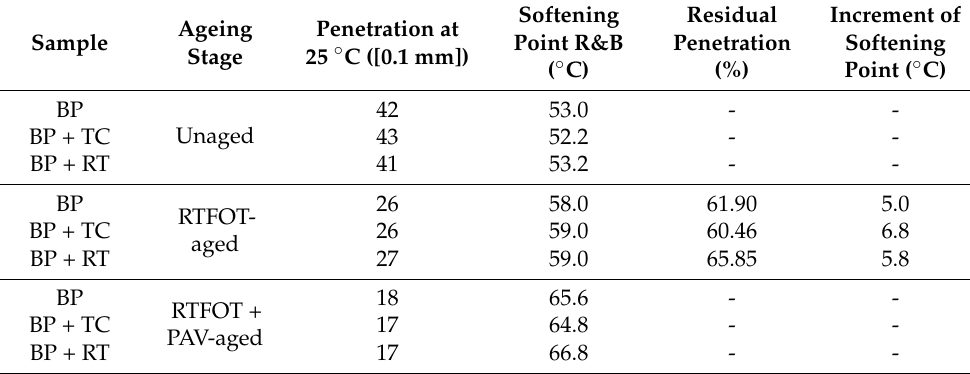
Table 2. Penetration and softening point tests